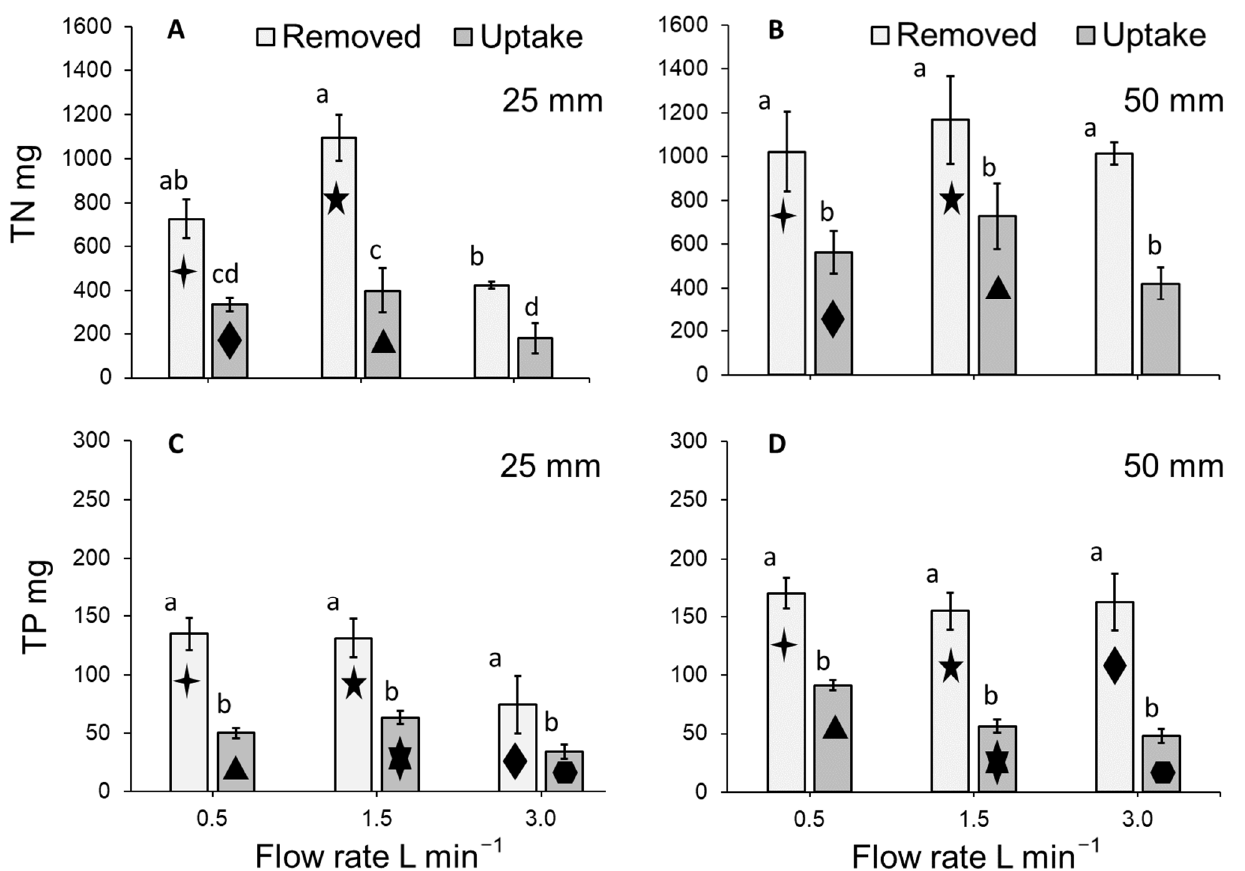
Figure 9. Mean ( ± SE) ( A , B ) total removal and total plant uptake of TN and ( C , D ) TP within the 125-litre stacked system. As no effect of tray was detected, trays have been pooled in this simplified model depiction. Letters show statistical similarity within each medium depth (i.e., within a panel), while symbols indicate similarity in relation to each flow rate across both medium depths ( p > 0.05).